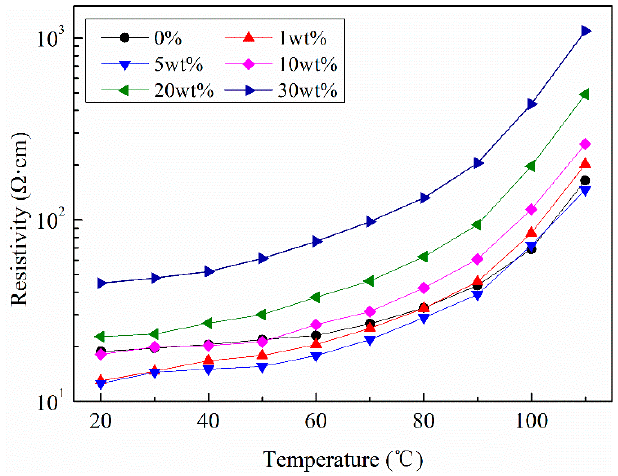
Figure 5. Resistivity of SrFe 12 O 19 /semi-conductive composites versus temperature.